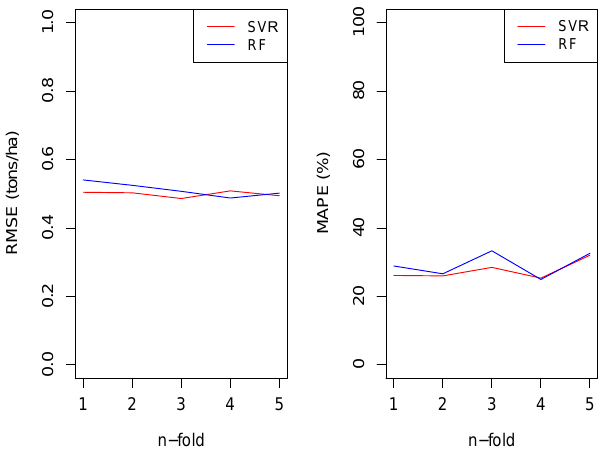
Figure 7. RMSE and MAPE from 5-fold cross-validation of RF and SVR maize prediction